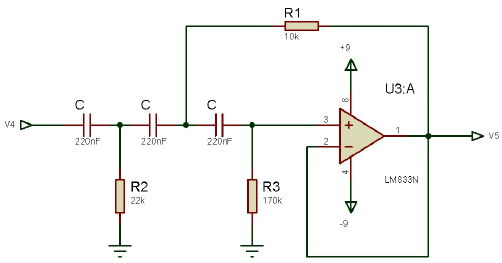
Figure 6. 3rd order high-pass butterworth